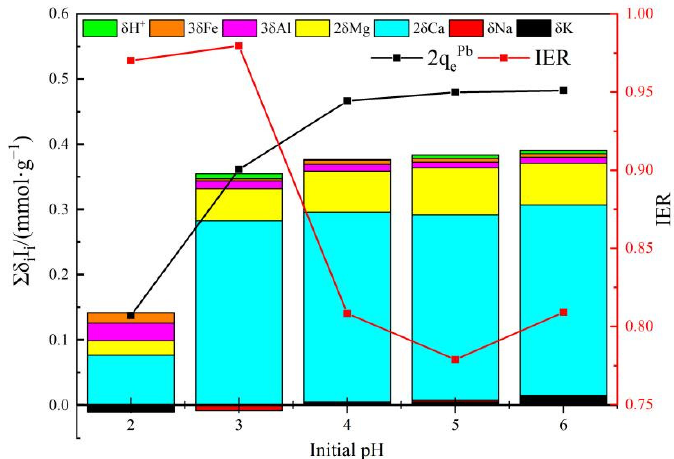
Figure 12. Phenomenological ion exchange in the adsorption of Pb( Ⅱ ) by